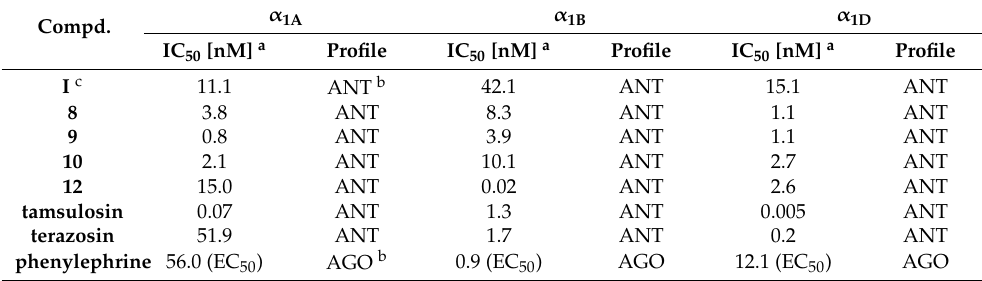
Table 2. The functional activity of selected derivatives and reference drugs for α 1A -, α 1B -, and α 1D -ARs. Compd.